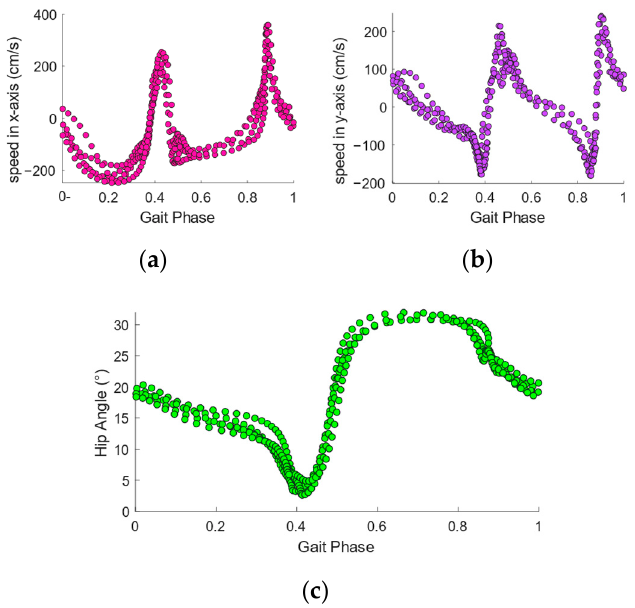
. Figure 4. ( a ) Scatter plot of x (cid:4662) b and gait phase. ( b ) Scatter plot of y (cid:4662) x b and gait phase. ( b ) Scatter plot of Figure 4. ( a ) Scatter plot of of hip joint angle q and gait phase. All those points are computed by motion capture data during of hip joint angle q h and gait phase. All those points are computed by motion capture data during h walking on the treadmill with a speed of 3 km/h. walking on the treadmill with a speed of 3